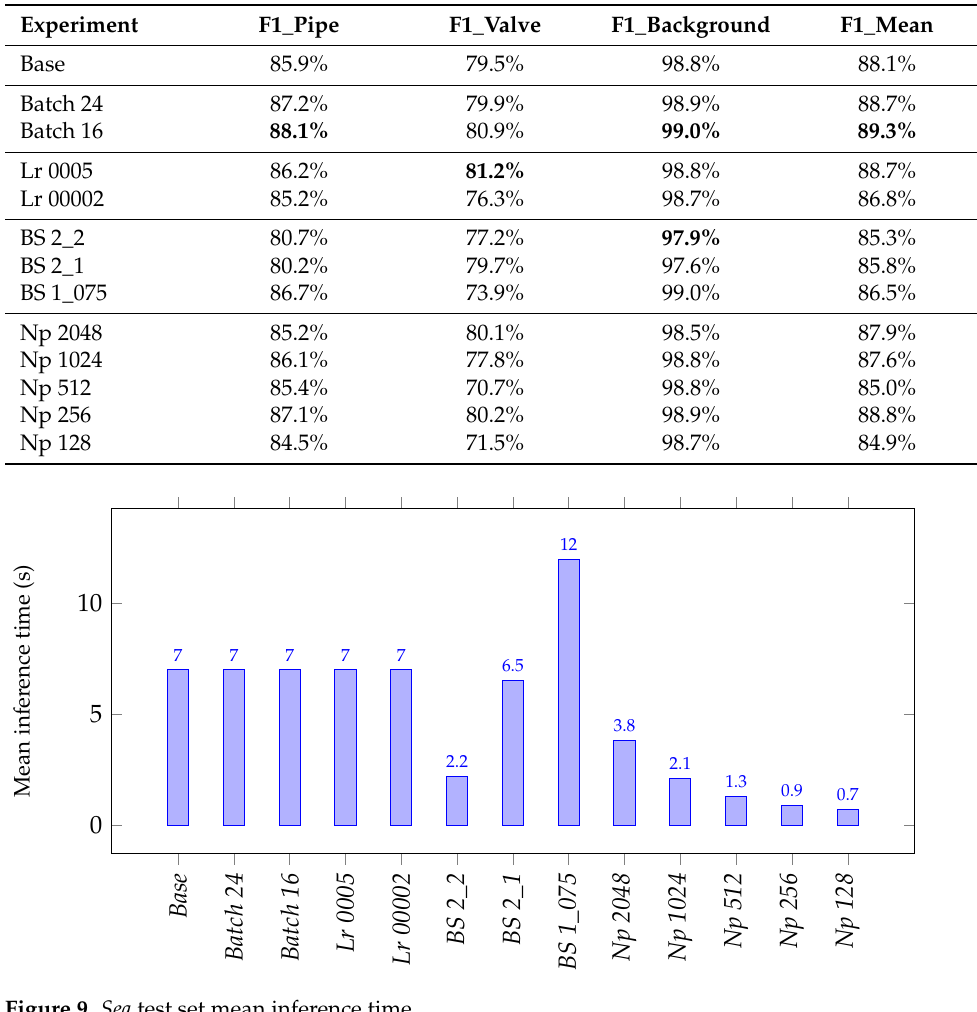
Table 3. Sea test set F1-scores .